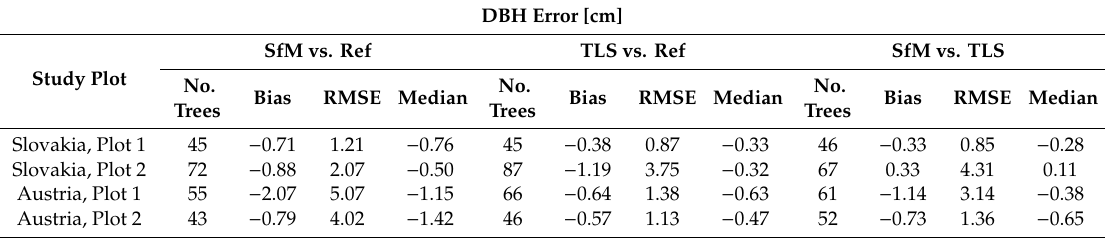
Figure 7. For each plot, and for both SfM and TLS, the DBH error in relation to the reference DBH. Table 5. The accuracy of the DBH estimates from SfM and TLS point clouds.